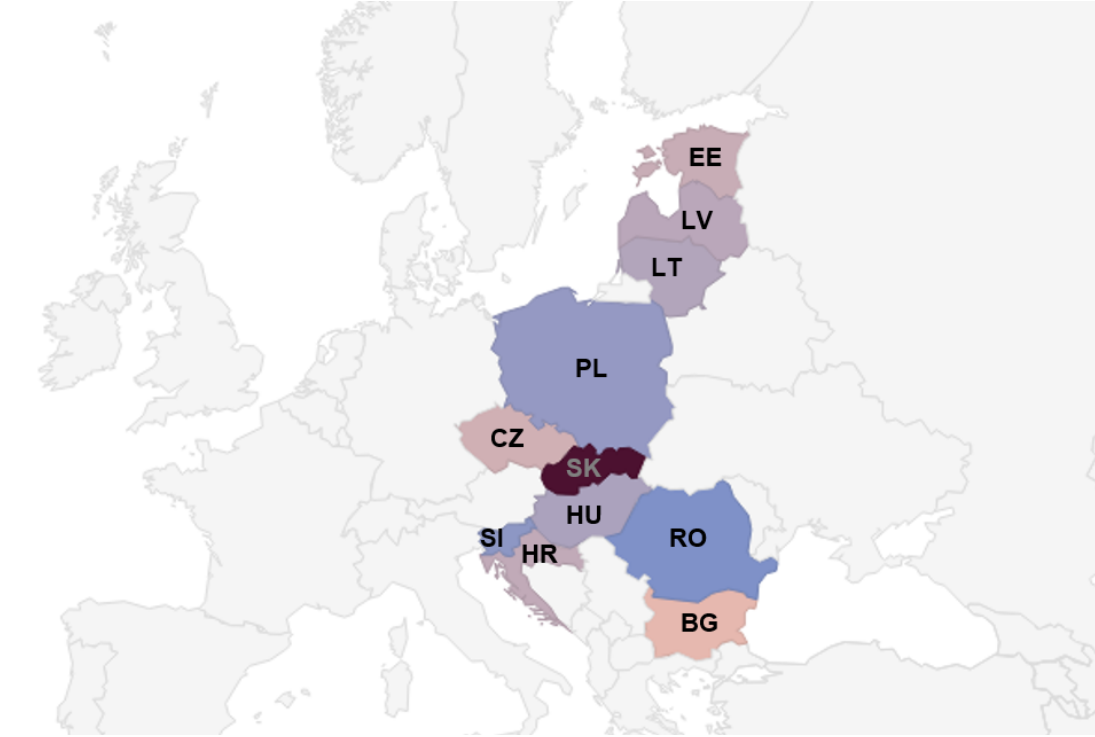
Figure 2. Location of Central and Eastern European (CEE) countries (own